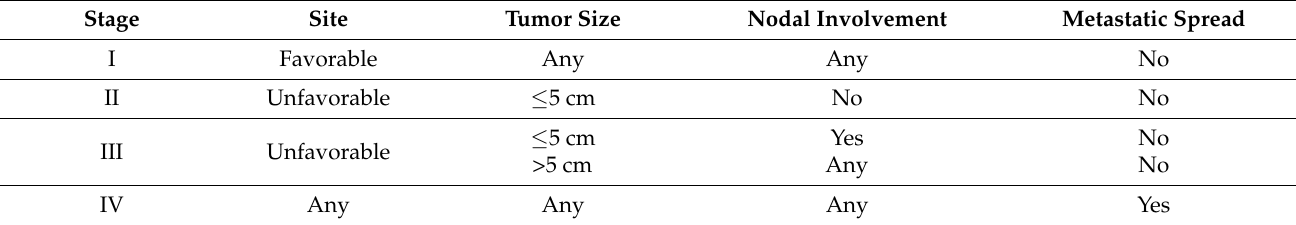
Table 1. Staging per Intergroup Rhabdomyosarcoma Study Group (IRSG) classifications.